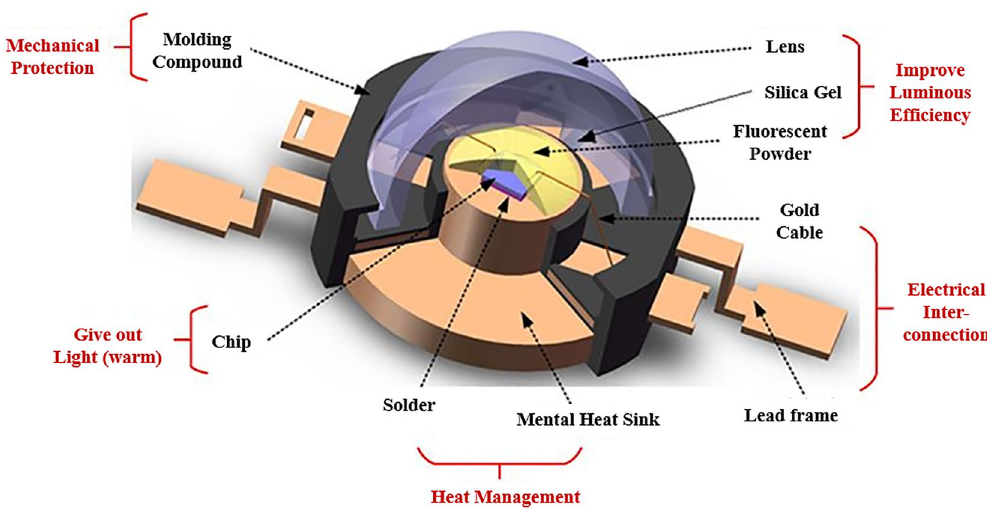
Figure 1. Integrated primary encapsulation and secondary optical design of the LED light